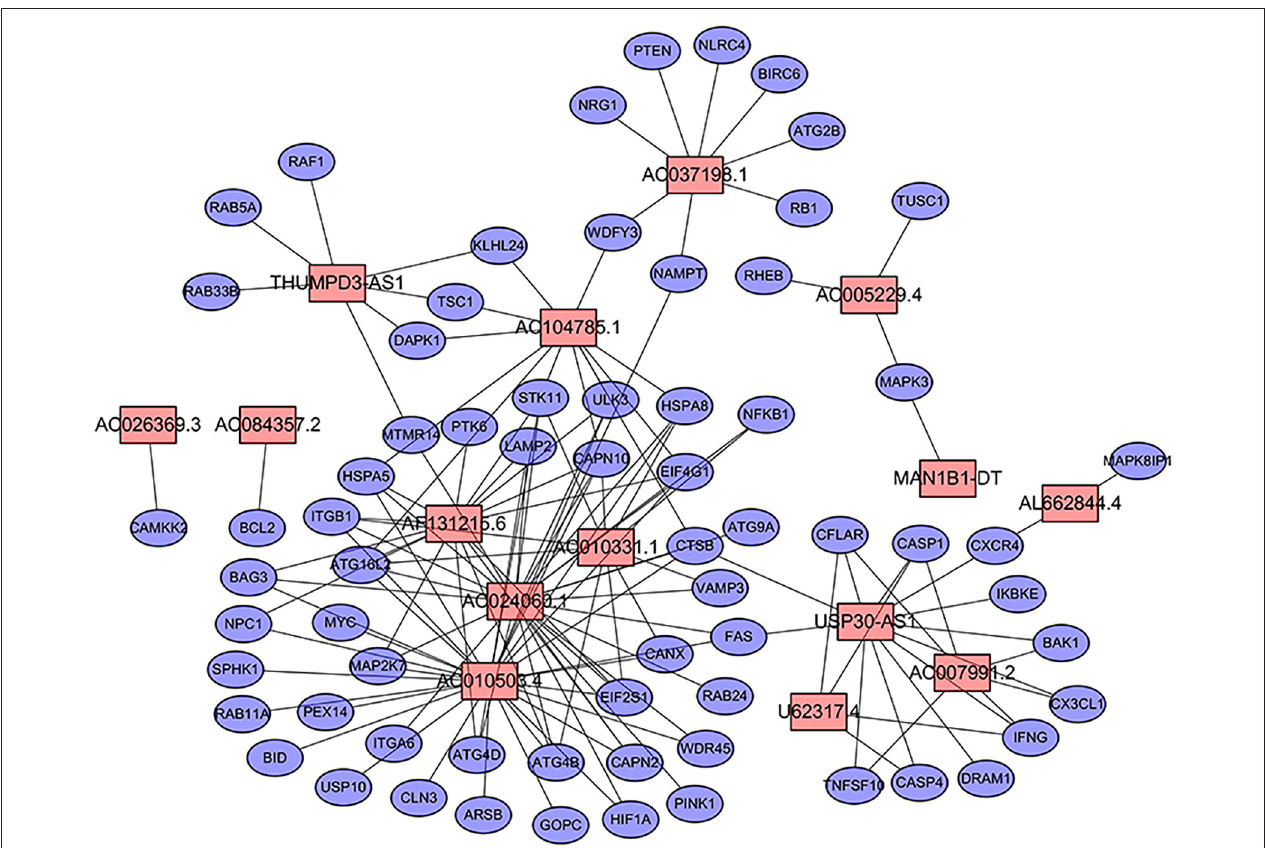
FIGURE 1 | Prognostic network of long non-coding RNAs (lncRNAs) and co-expressed autophagy genes in bladder cancer (BC). In the center, the red node represents lncRNA, and the blue represents autophagy genes. The co-expression network was constructed by using CYTOSCAPE 3.7.2